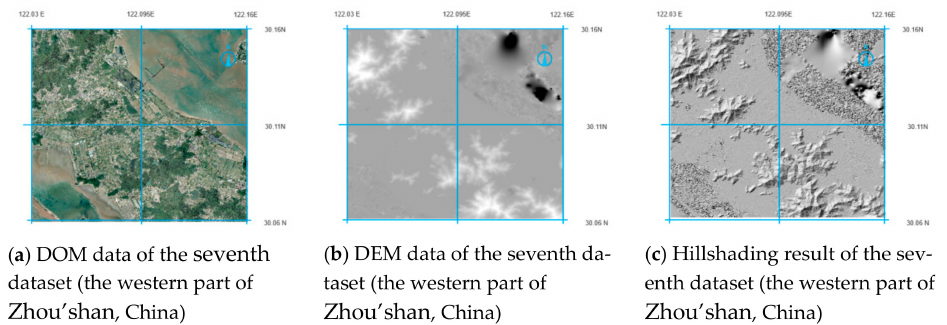
Figure 32. The experimental seventh dataset:( a ) DOM data of the seventh dataset (western part of Zhou’shan, China); ( b ) DEM data of the seventh dataset (western part of Zhou’shan, China); ( c ) Hillshading result of the seventh dataset (western part of Zhou’shan, China).